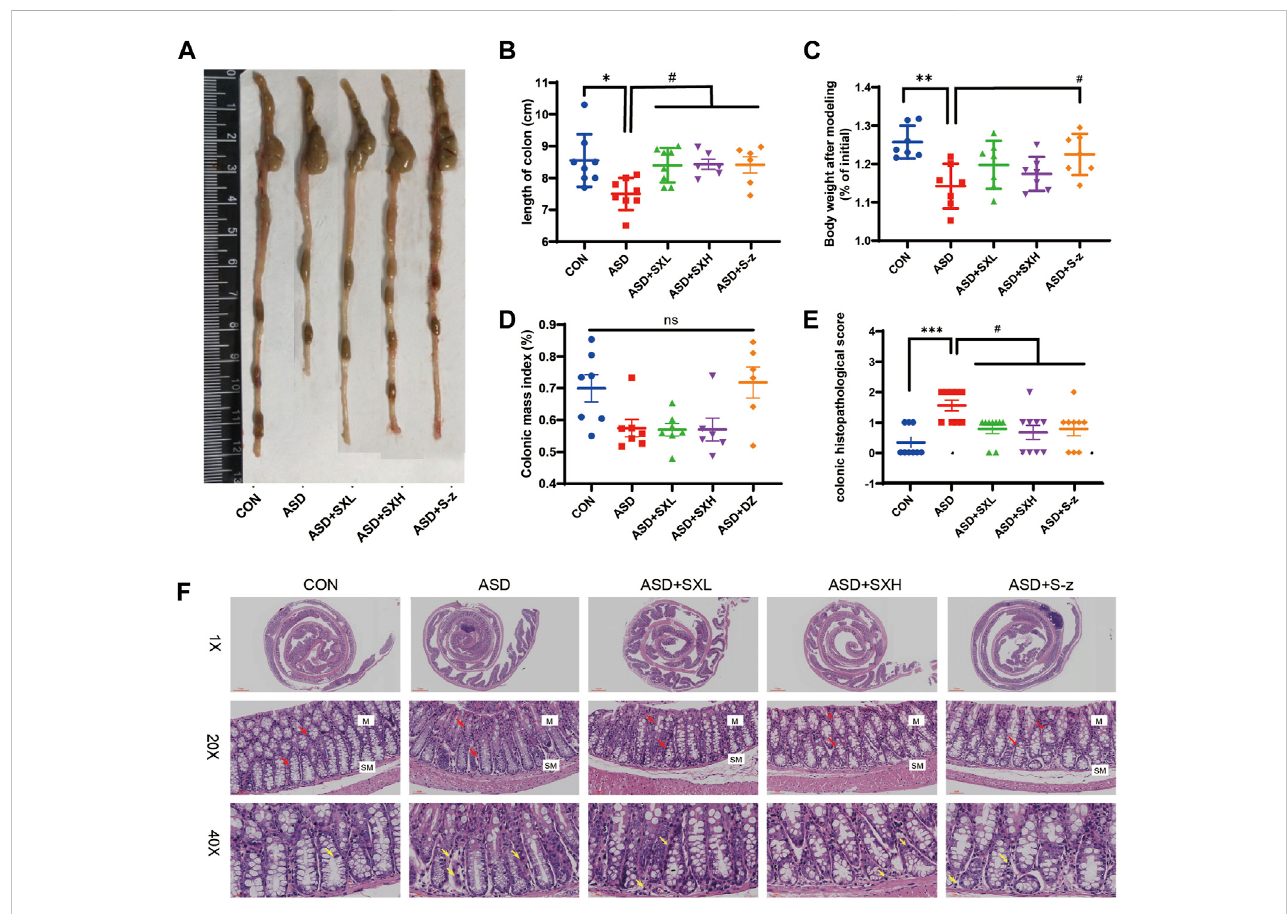
FIGURE 2 SXalleviatesacutesleepdeprivation-inducedhistopathological injuryinthecolon. (A) Representativeimagesshowthelengthsofcolonsharvestedfrom theCON,ASD,ASD+SXL,ASD+SXH,andASD+S-zgroupsofmice. (B) QuantitativedatashowsthecolonlengthsofmicebelongingtotheCON,ASD,ASD+ SXL, ASD+ SXH, and ASD + S-z groups. (C) Body weights of the CON, ASD, ASD + SXL, ASD + SXH, and ASD + S-z group mice after modeling. (D) Colon mass indices (%)(colonicweight/body weight) of theCON, ASD,ASD+ SXL, ASD+ SXH,and ASD+ S-z groupsof mice. (E) The colon histopathologicalscores of the CON, ASD, ASD + SXL, ASD + SXH, and ASD + S-z group mice. p < 0.05, ASD vs. SXL, SXH and S-z. (F) Representative H&E-stained images show the morphological changes in the colon mucosa of mice belonging to the CON, ASD, ASD + SXL, ASD + SXH, and ASD + S-z groups (×1, ×20, and×40magni fi cation).M:mucosa;SM:submucosa;redarrow:multiplemucinousglands;yellowarrow:in fl ammatorycells.Datawereexpressedasmeans± SEM. n = 6 – 7 per group. Statistical signi fi cance was determined by one-way ANOVA; * p < 0.05 vs. control group; # p < 0.05 vs. ASD group; ns, no signi fi